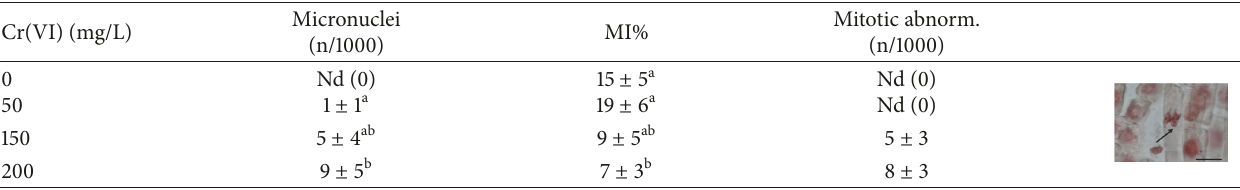
Table 3: Micronuclei and mitotic index and abnormalities in roots of L. sativa L. exposed to Cr(VI). Values are presented as the mean ± standard deviation. Different letters indicate for the same parameter significantly different means ( 𝑝 < 0.05 ). Image: microphotograph of an abnormal metaphase in roots (bar = 20 𝜇